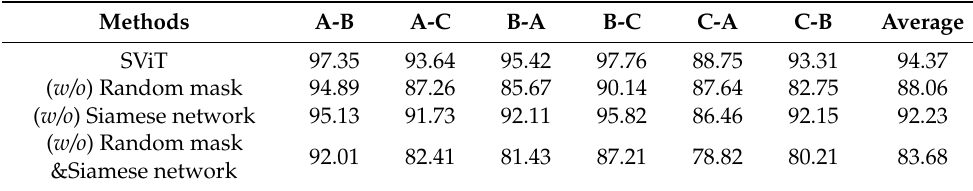
Table 7. Ablation experiments with 600 training samples.